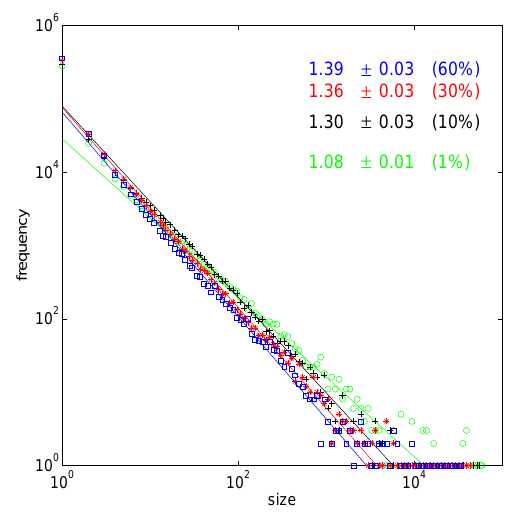
Figure 2. The scaling exponents (denoted along with the standard errors) of the log–log frequency–size plots of the four cases of dis- tinct heterogeneity coverages (with corresponding color markers) increase systematically for low coverage extent under 30%, and ap- proach asymptotically toward 1.41 beyond 30% and up to 99% (not shown here) coverage (note that the data are simplified by the bin- ning the same as Fig.